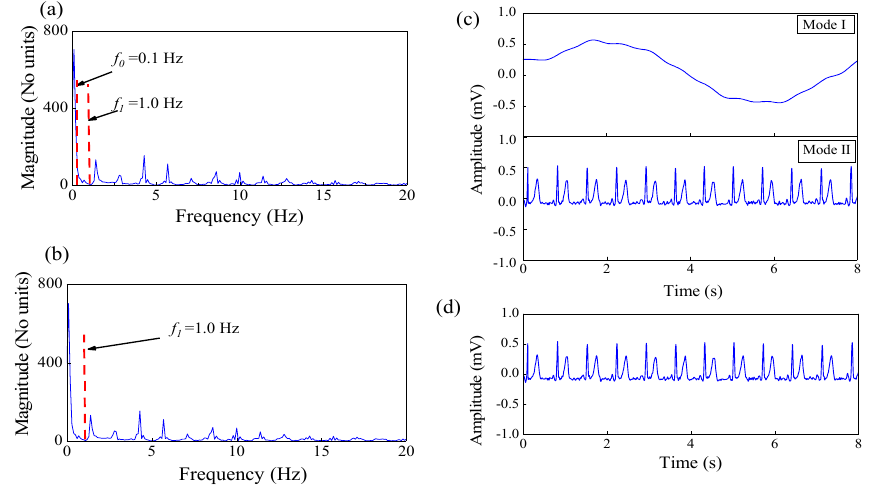
Figure 4. Segmentation of the Fourier spectrum of the ECG signal contaminated by motion artifacts. ( a ) Original spectral-boundary and ( b ) final spectral-boundary; ( c ) Modes extracted by the EWT and ( d ) EWT reconstructs ECG signals.